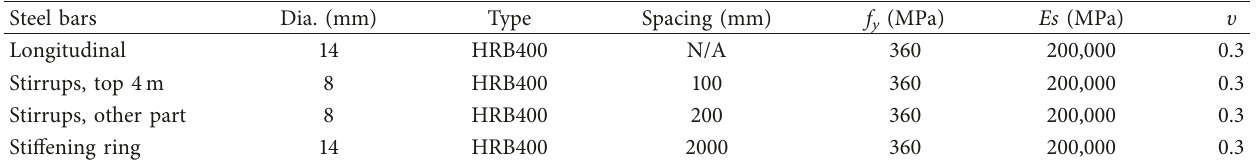
Table 2: Information of tested piles.